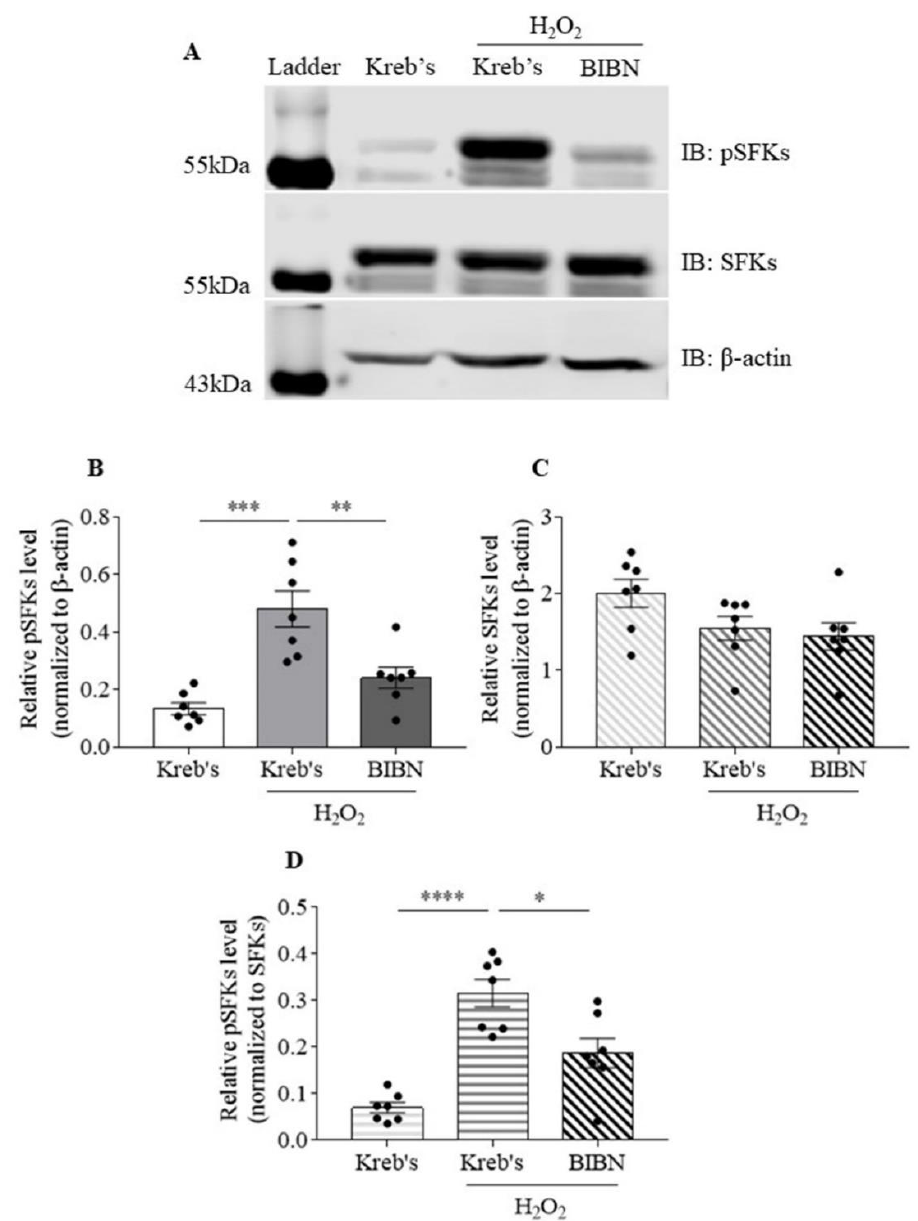
Figure 5. The protein level of phosphorylated SFKs at Y416 was increased by H 2 O 2 in the mouse TG. ( A ) The representative W estern blot bands of phosphorylated SFKs at Y416, SFKs, and β -actin sub- jected to the treatment with Kreb’s, 1 mM H 2 O 2 , or 10 µM BIBN4096 in the presence of 1 mM H 2 O 2 . ( B – D ) Effects of Kreb’s, 1 mM H 2 O 2 , or 10 µM BIBN4096 in the presence of 1 mM H 2 O 2 ( n = 7 per group) at 20 min post treatment on the protein levels of phosphorylated SFKs at Y416 and SFKs relative to that of β -actin and on the protein level of phosphorylated SFKs at Y416 relative to that of SFKs, all of which were presented in the absolute ratio. Abbreviations: BIBN4086 (BIBN), phosphor- ylated SFKs at Y416 (pSFKs). Two-tailed unpaired t -test was used for the comparison in the protein level of phosphorylated SFKs at Y416 between the H 2 O 2 group and either the Kreb’s group or the BIBN4096 in the presence of 1 mM H 2 O 2 group. Significant differences were labeled as * p < 0.05, ** p < 0.01, *** p < 0.001, or **** p < 0.0001. Original western blot images for the representative images in Figure 5 was shown in Supplementary Figure S2.